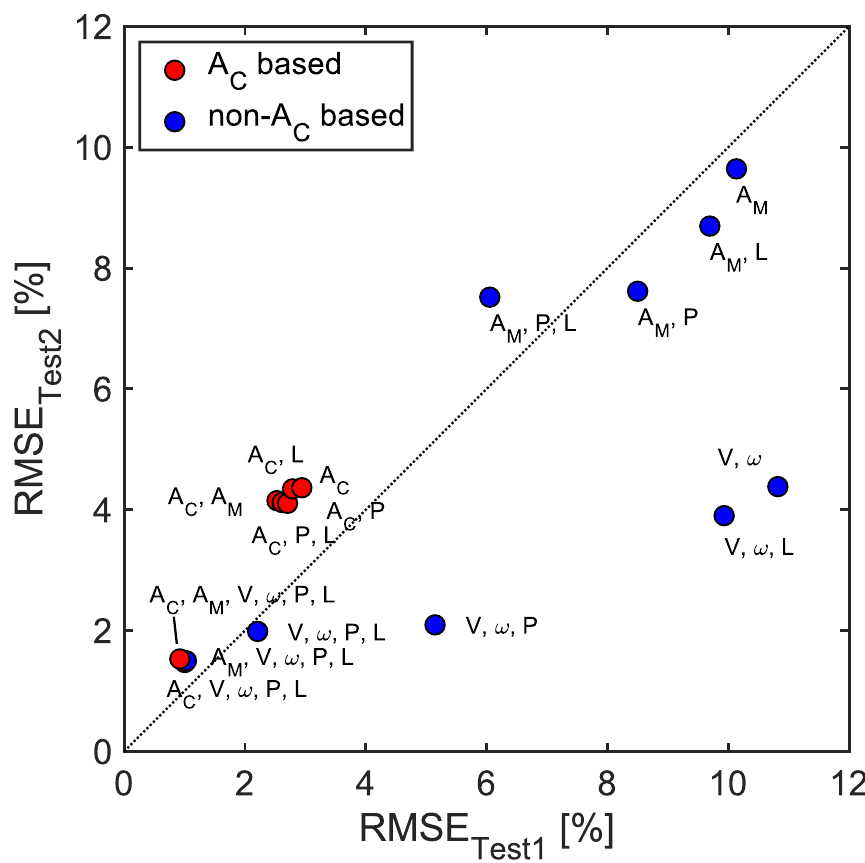
Figure 16. Comparison of prediction errors between the Test1 and Test2 data sets.